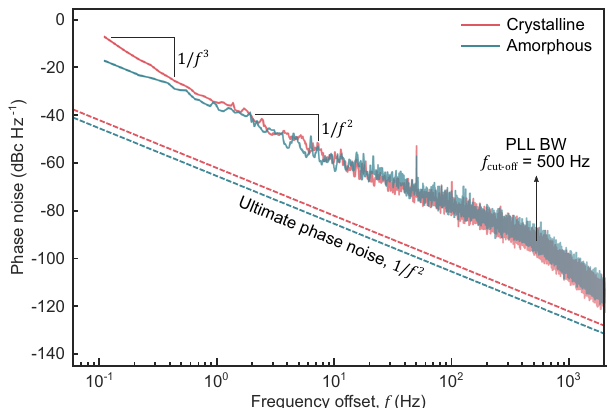
Fig. 4 Open-loop phase noise performance of the resonator in crystalline and amorphous states. The measured phase noise data is given by the red solid line in the crystalline state and by the green solid line in an amorphous state, for a carrier signal power of 1.6 nW. The dashed lines of the same colors show the ultimate phase noise performance of the device in corresponding states. This thermomechanical limit can be reached by optimizing the external